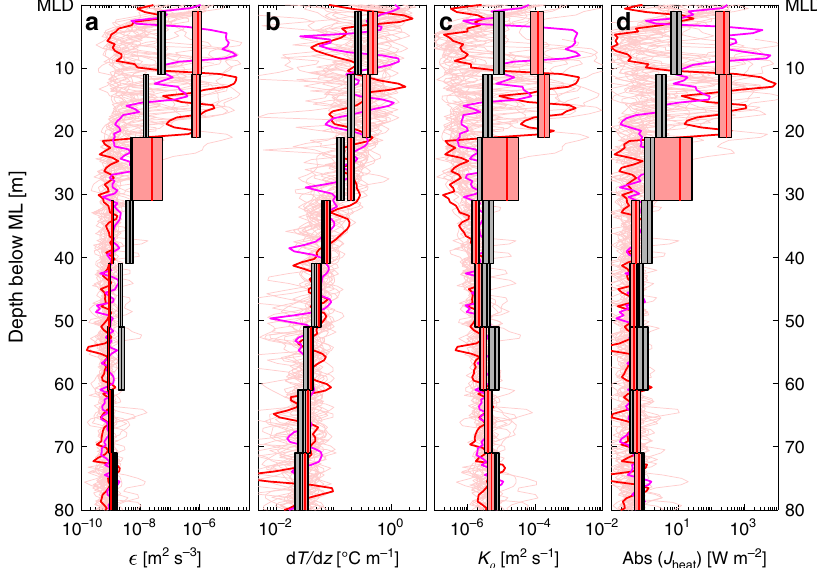
Fig. 4 Observed mixing parameters near 11.5°N, 23°W. 10-m average pro fi les observed with the microstructure pro fi ler (MSS) in the vicinity of the PIRATA buoy of a turbulent dissipation rates ( ε ), b vertical temperature gradients (d T /d z ), c eddy diffusivities ( K ρ ) and d vertical diffusive heat fl uxes ( J heat ) during September 2015 as thick red bars. All additionally available MSS observations of the other cruises in thick black 10-m average bars. Gray/light red patches around the bars denote the 95% con fi dence limits. Light red lines show the individual pro fi les with full vertical resolution from September 2015, where two exemplary pro fi les are highlighted in red/magenta. The two highlighted pro fi les are also localized as red/magenta diamonds in Fig.